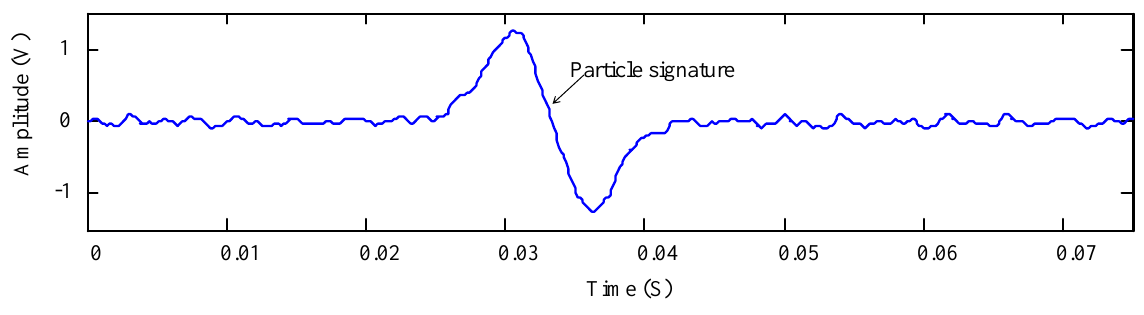
Figure 2. Signal obtained from an oil debris sensor with a single particle (enlarged view in temporal